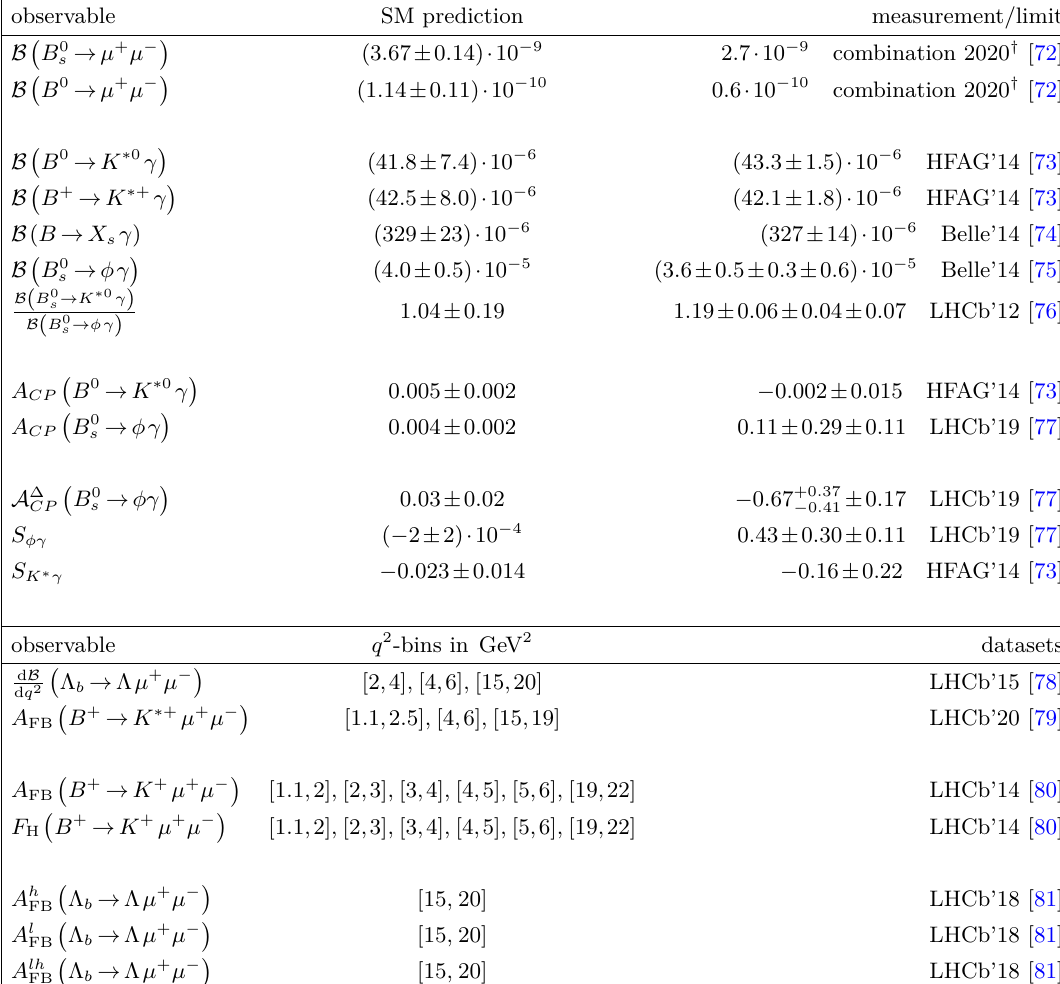
Table 7 . Additional input for the performed global fit, which is not listed in ref.